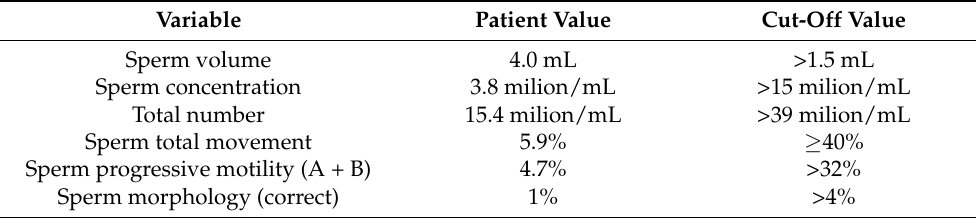
Table 1. Semen analysis of the patient. Cut of values according to the WHO Laboratory Manual for the Examination and Processing of Human Semen, 5th